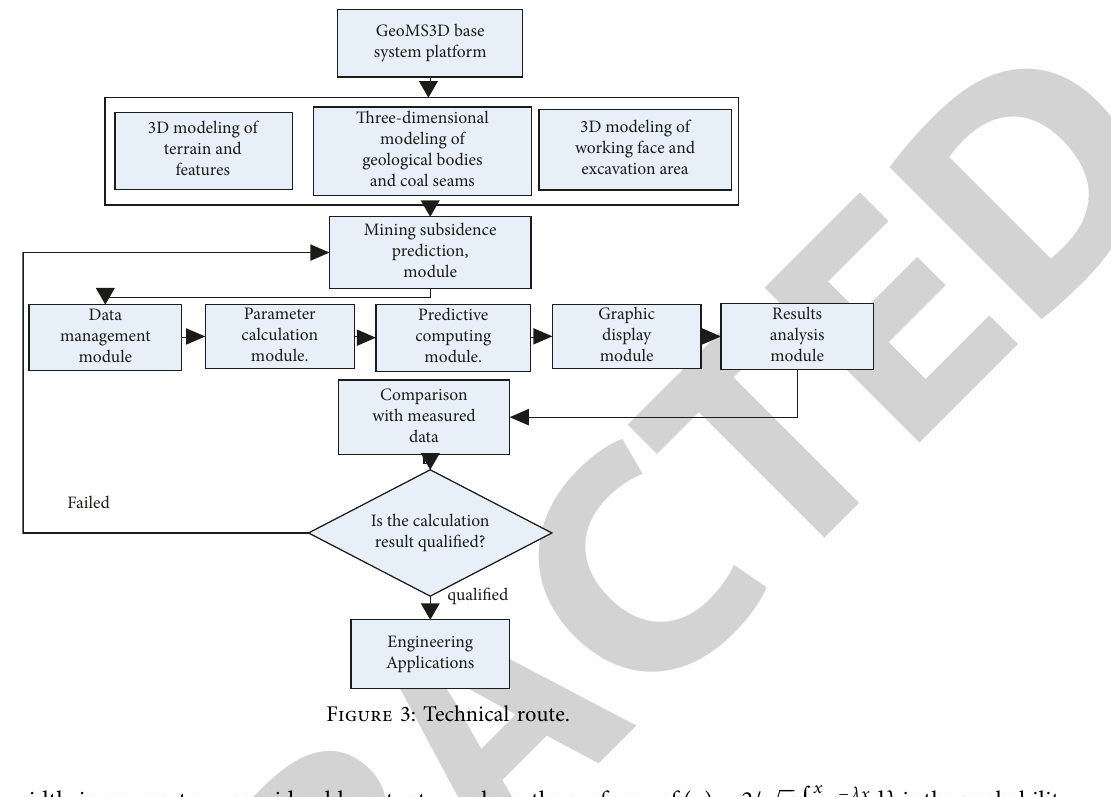
Figure 3: Technical